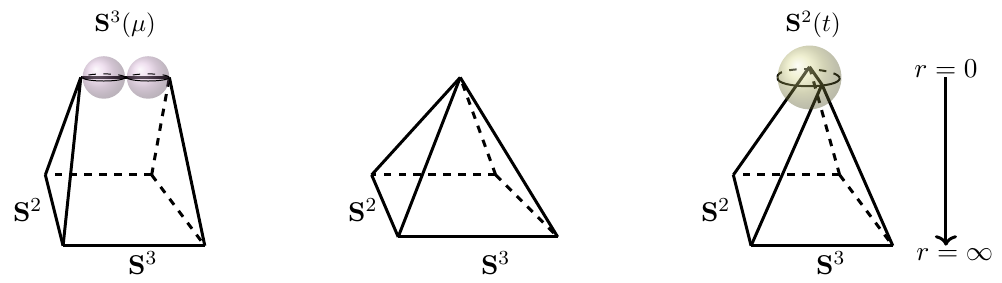
Figure 1 . A illustration of the deformed, singular, and resolved conifold geometries viewed as a cone with a base that is topologically S 2 (cid:2) S 3 . We view the base as living far out along the cone r ! 1 , and the di(cid:11)erent topologies of the three geometries are captured by the behaviour near the tip. In the deformed conifold (left), S 2 shrinks to a point and the S 3 has radius (cid:22) . The singular conifold (middle) instead has both the S 3 and the S 2 shrinking to a point at the tip. In the resolved conifold (right) on the other hand, the S 3 shrinks to a point and the S 2 has the K(cid:127)ahler parameter t . We have drawn the three-sphere as two 3-balls, which are to be identi(cid:12)ed along their boundaries. We will use this representation explicitly below, and also adhere to the color coding